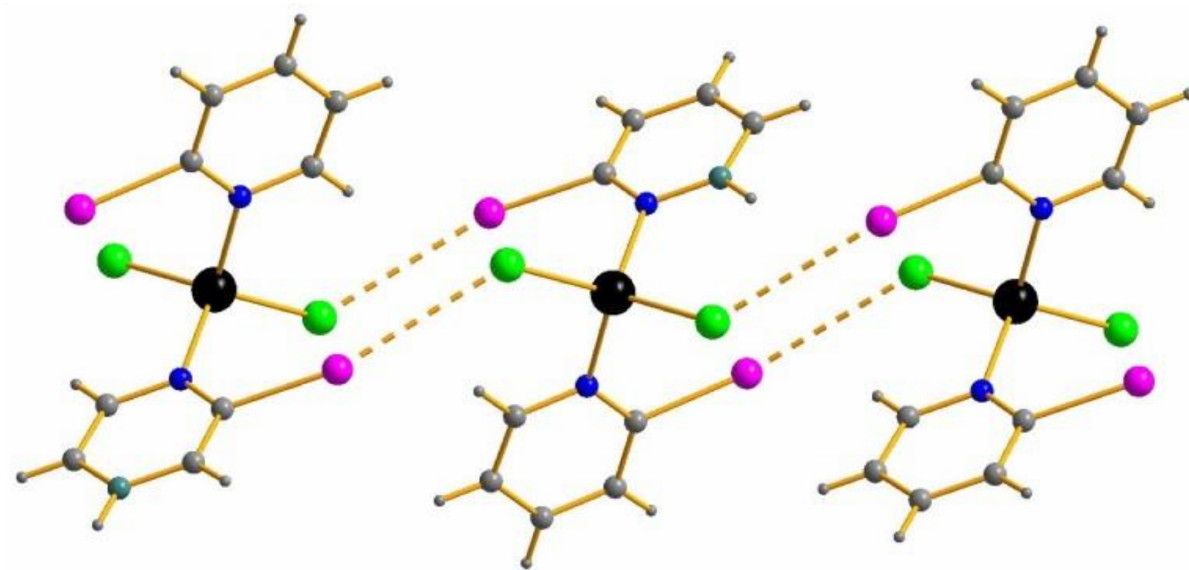
Figure 2. I ··· Cl contacts (dashed) in the structure of 3 . I